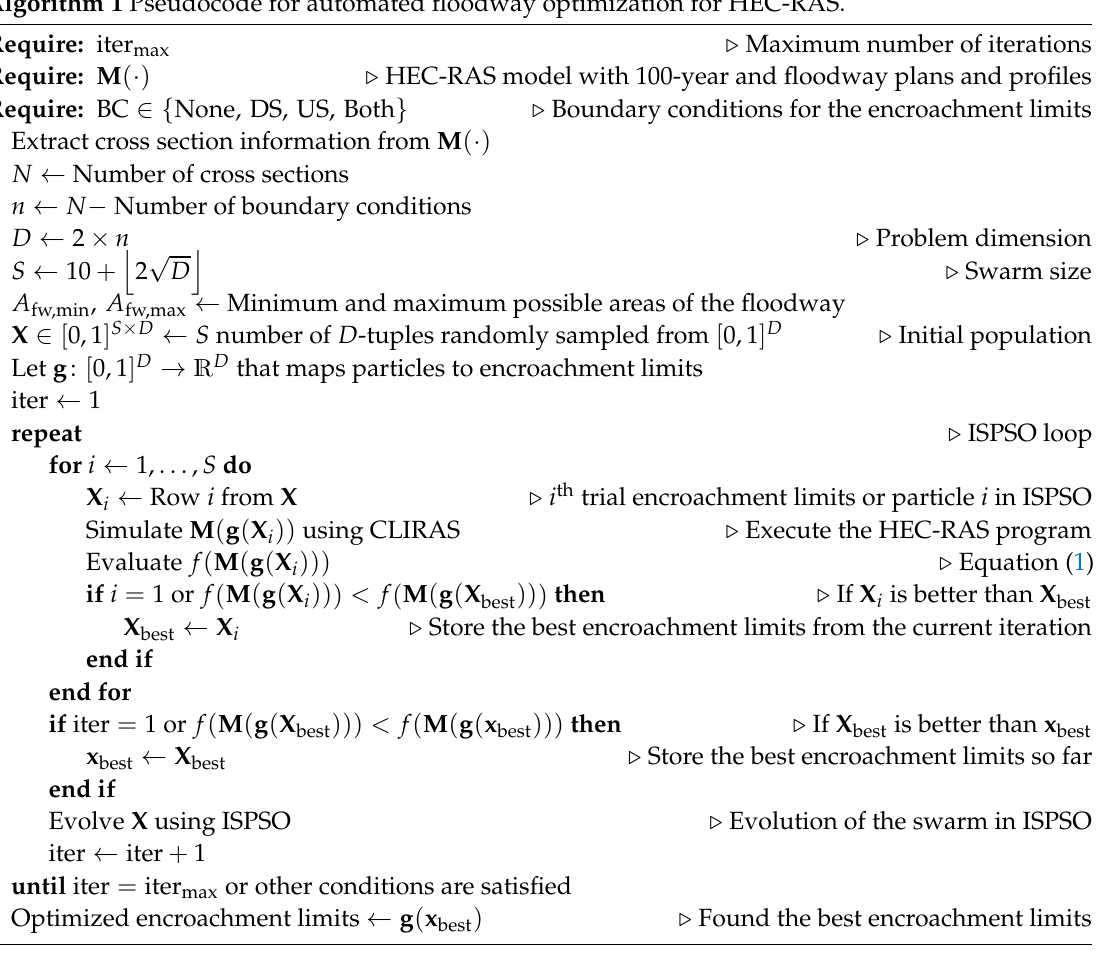
Algorithm 1 Pseudocode for automated floodway optimization for